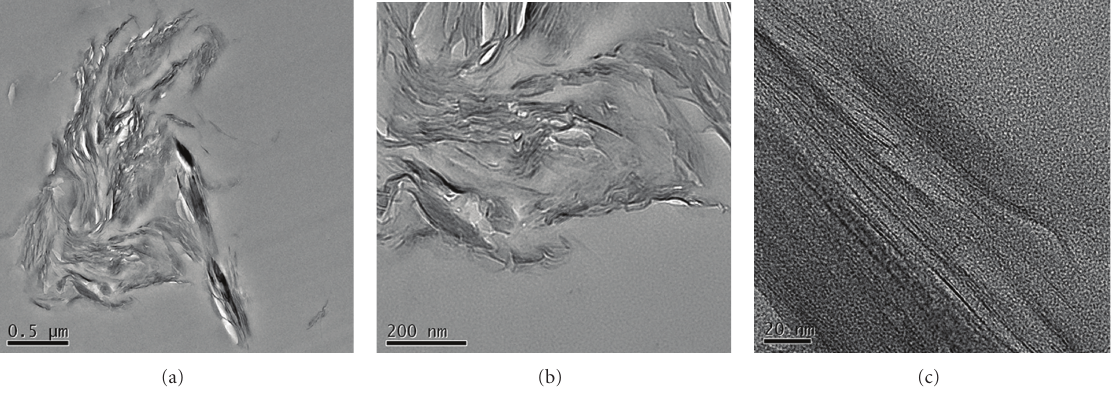
Figure 11: TEM images of epoxy/clay nanocomposites via shear mixing method at di ff erent magnifications.